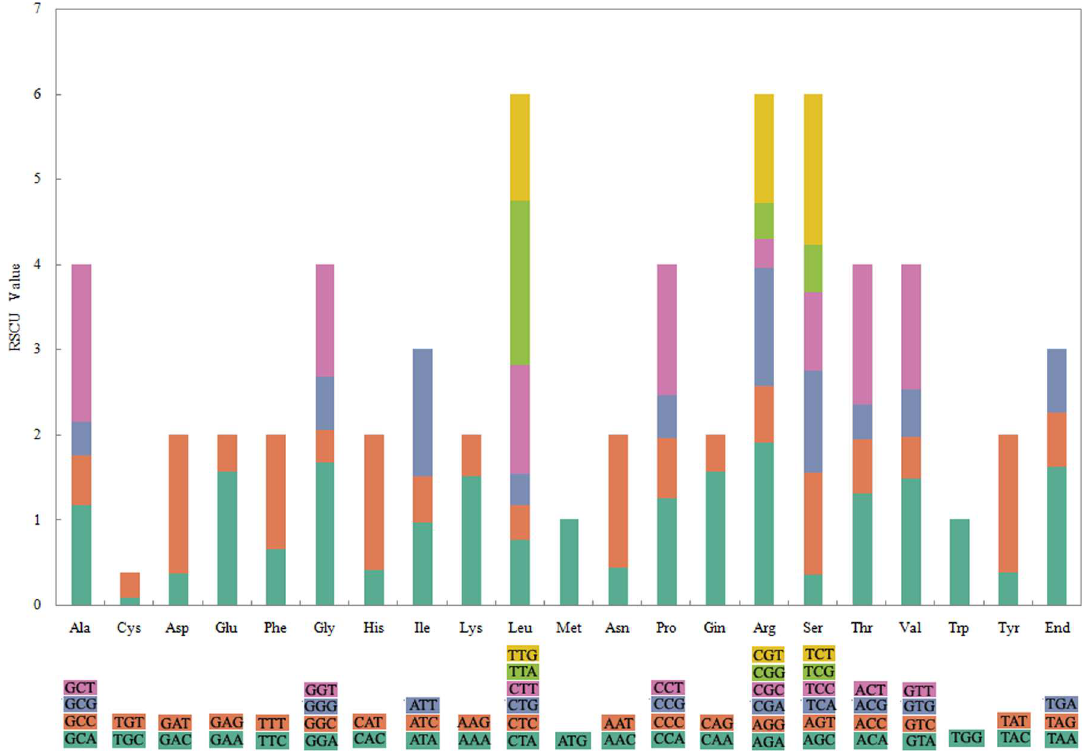
Fig 5. Codon content of 20 amino acid and stop codons in all protein-coding